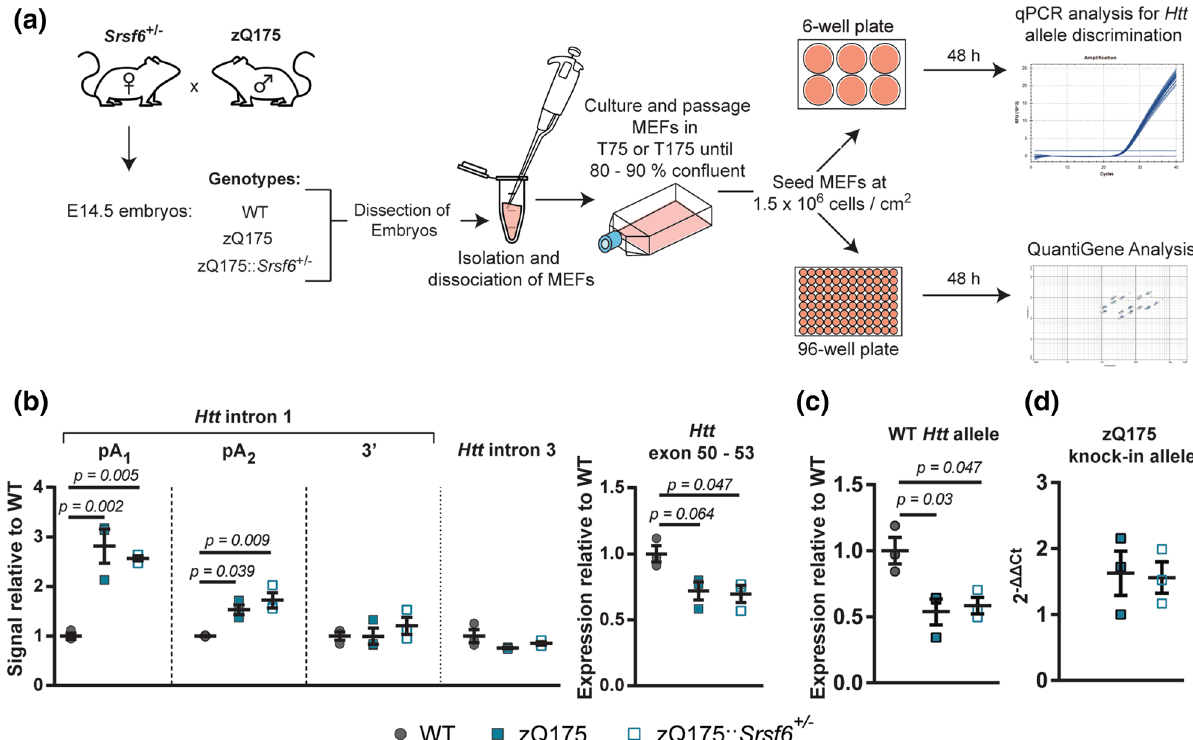
Figure 3. Generation and characterisation of zQ175 mouse embryonic fibroblasts (MEFs). ( a ) Schematic shows workflow for derivation and characterisation of MEF cell cultures. Srsf6 + /− mice were bred to zQ175 mice. The female was sacrificed at approximately E14.5 and embryos were dissected. Mouse embryonic fibroblasts (MEFs) were isolated, cultured, passaged and expanded as required. MEFs were seeded for qPCR or QuantiGene assays as required. ( b ) QuantiGene analysis showed that Httexon1 was present in both the zQ175 and zQ175:: Srsf6 + /− MEFs at comparable levels, and that full-length Htt was decreased in both the zQ175 and zQ175:: Srsf6 +/− cells to a similar degree. n = 3 biological replicates/genotype. Statistical analysis was by one-way ANOVA with Bonferroni correction for multiple pairwise comparisons, ***p < 0.001. Test statistics can be found in Supplementary Table S6. ( c , d ) Htt allele discrimination qPCRs were used to measure the ( c ) WT and ( d ) zQ175 knockin Htt alleles in the MEF lines. n = 3 biological replicates/genotype. Statistical analysis was by unpaired Student’s t -test or one-way ANOVA with Bonferroni correction for multiple pairwise comparisons, *** p < 0.001, p < 0.2 values are indicated. Test statistics can be found in Supplementary Table